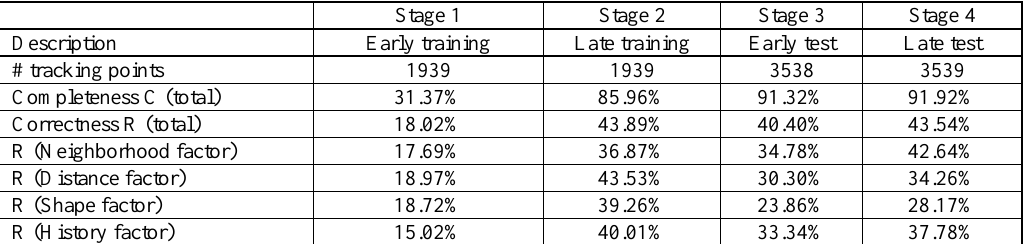
Table 1: Evaluation of the completeness (C) and correctness (R) of the prediction based on the video tracking datasets dataset consist of 11 long trajectories (9627 tracking points). It shows different routes through the city taken by the participants.